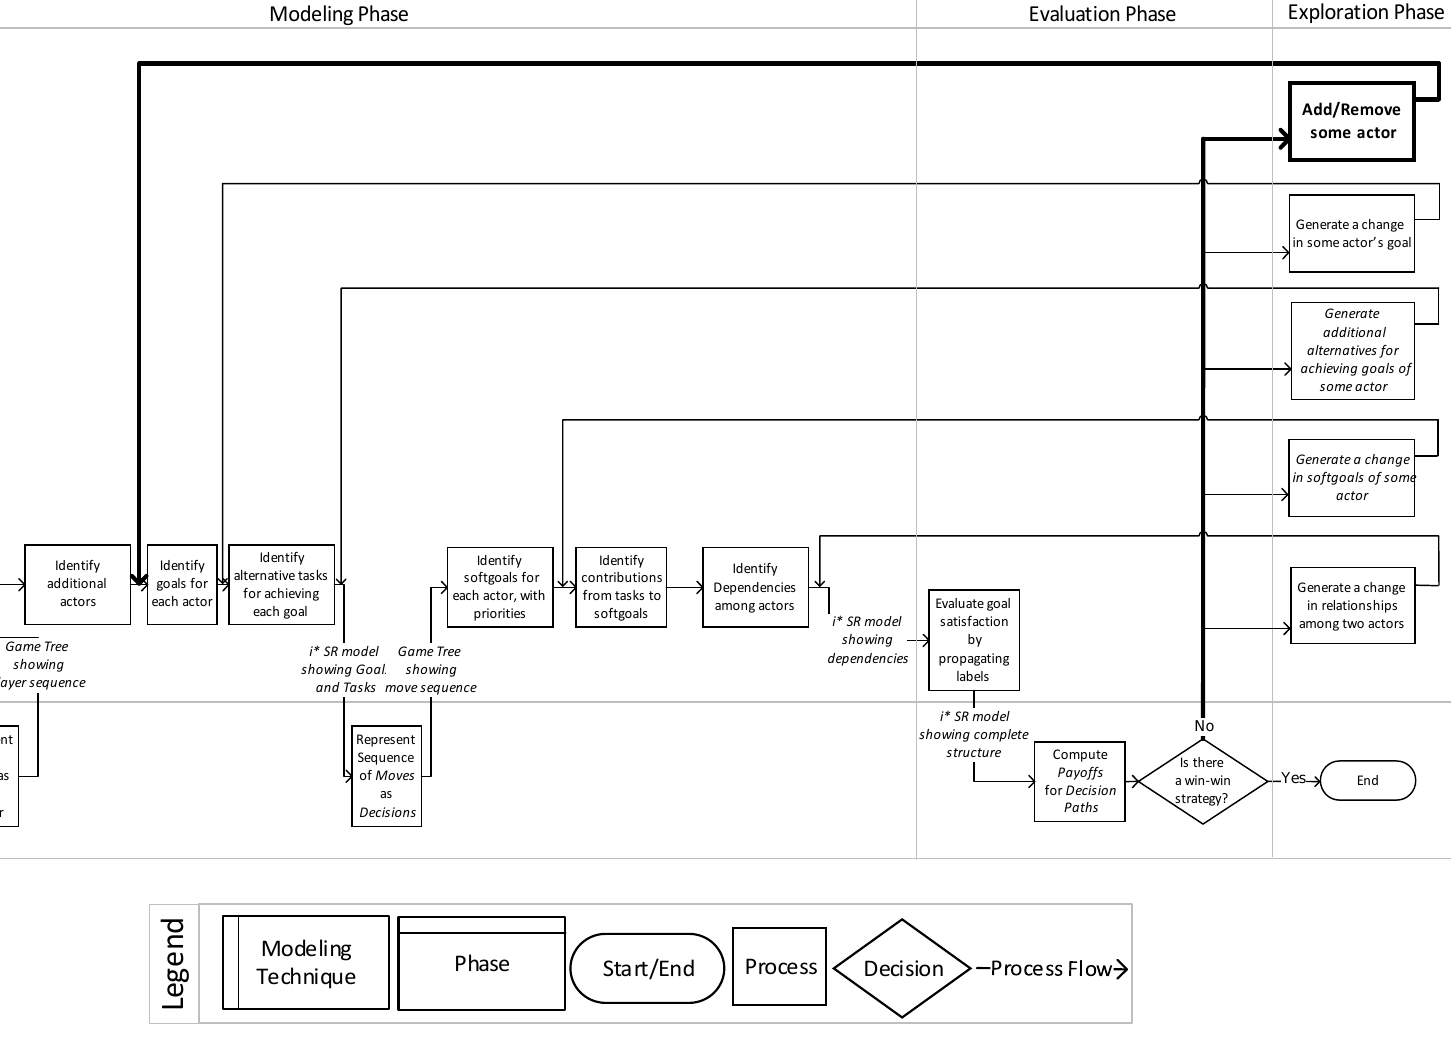
Figure 1. Process steps for alternating between i* and Game Tree modeling to get to win-win (Introduction of new actor is highlighted in bold , softgoal and tasks in italics